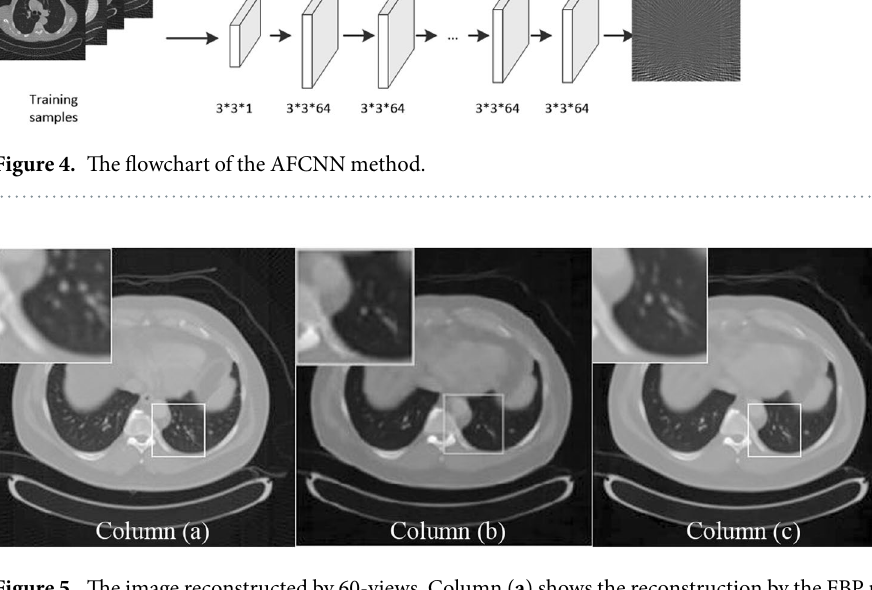
Figure 5. The image reconstructed by 60-views. Column ( a ) shows the reconstruction by the FBP method from the full projection views. Column ( b ) shows the reconstruction with artifacts by the one scale CNN method from the sparse projection views. Column ( c ) shows the artifacts-free reconstruction by the proposed method.